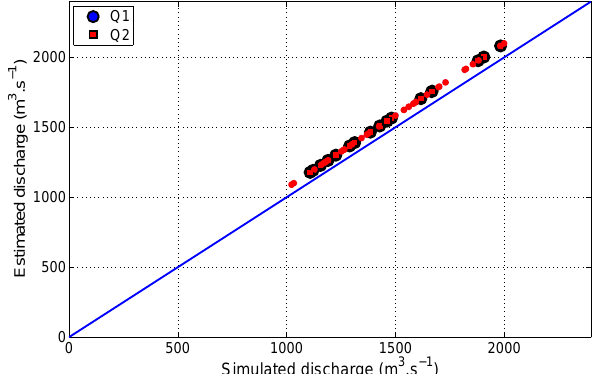
Fig. 3. Representation of the estimated discharge using Eqs. (8) and (9) against simulated discharge measurements. The calibration points are plotted with blue and red stars for Q 1 and Q 2 respectively